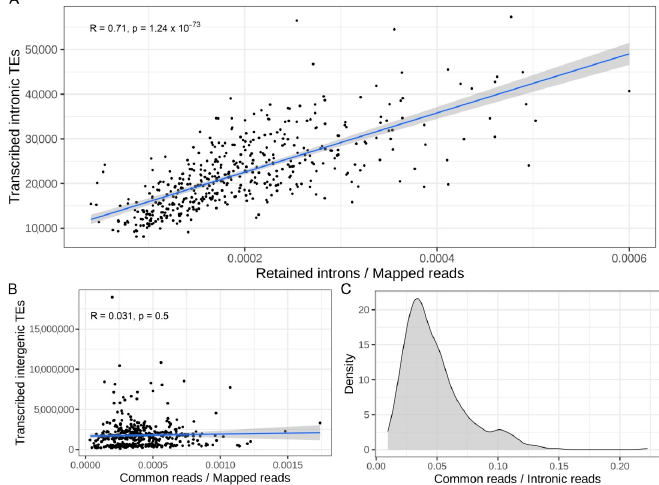
Figure 3. Increased intron retention correlates with an increased number of expressed intronic TEs. ( A ) Correlation between normalized retained introns counts and the number of transcribed intronic TEs per sample. On the top of the plot the coefficients of correlation (R) and the p -value are reported. ( B ) Correlation between normalized number of reads in common between TEs in RI and intergenic TEs and the number of transcribed intergenic TEs per samples are reported. On the top of the plot the coefficients of correlation R and the p -value are shown. ( C ) Distribution of the number of common multi-mapping reads among TEs located in retained introns and intergenic TEs per sample. The number is reported as a fraction with respect to the total number of reads mapped in TEs located in retained introns.